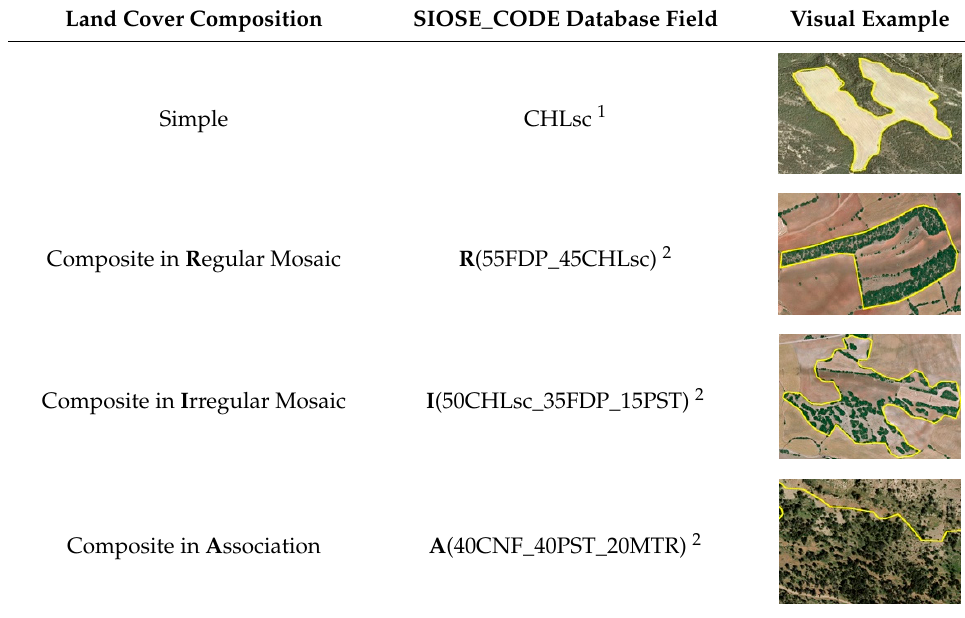
Table 1. Land cover composition and spatial distribution labelling within SIOSE polygons.